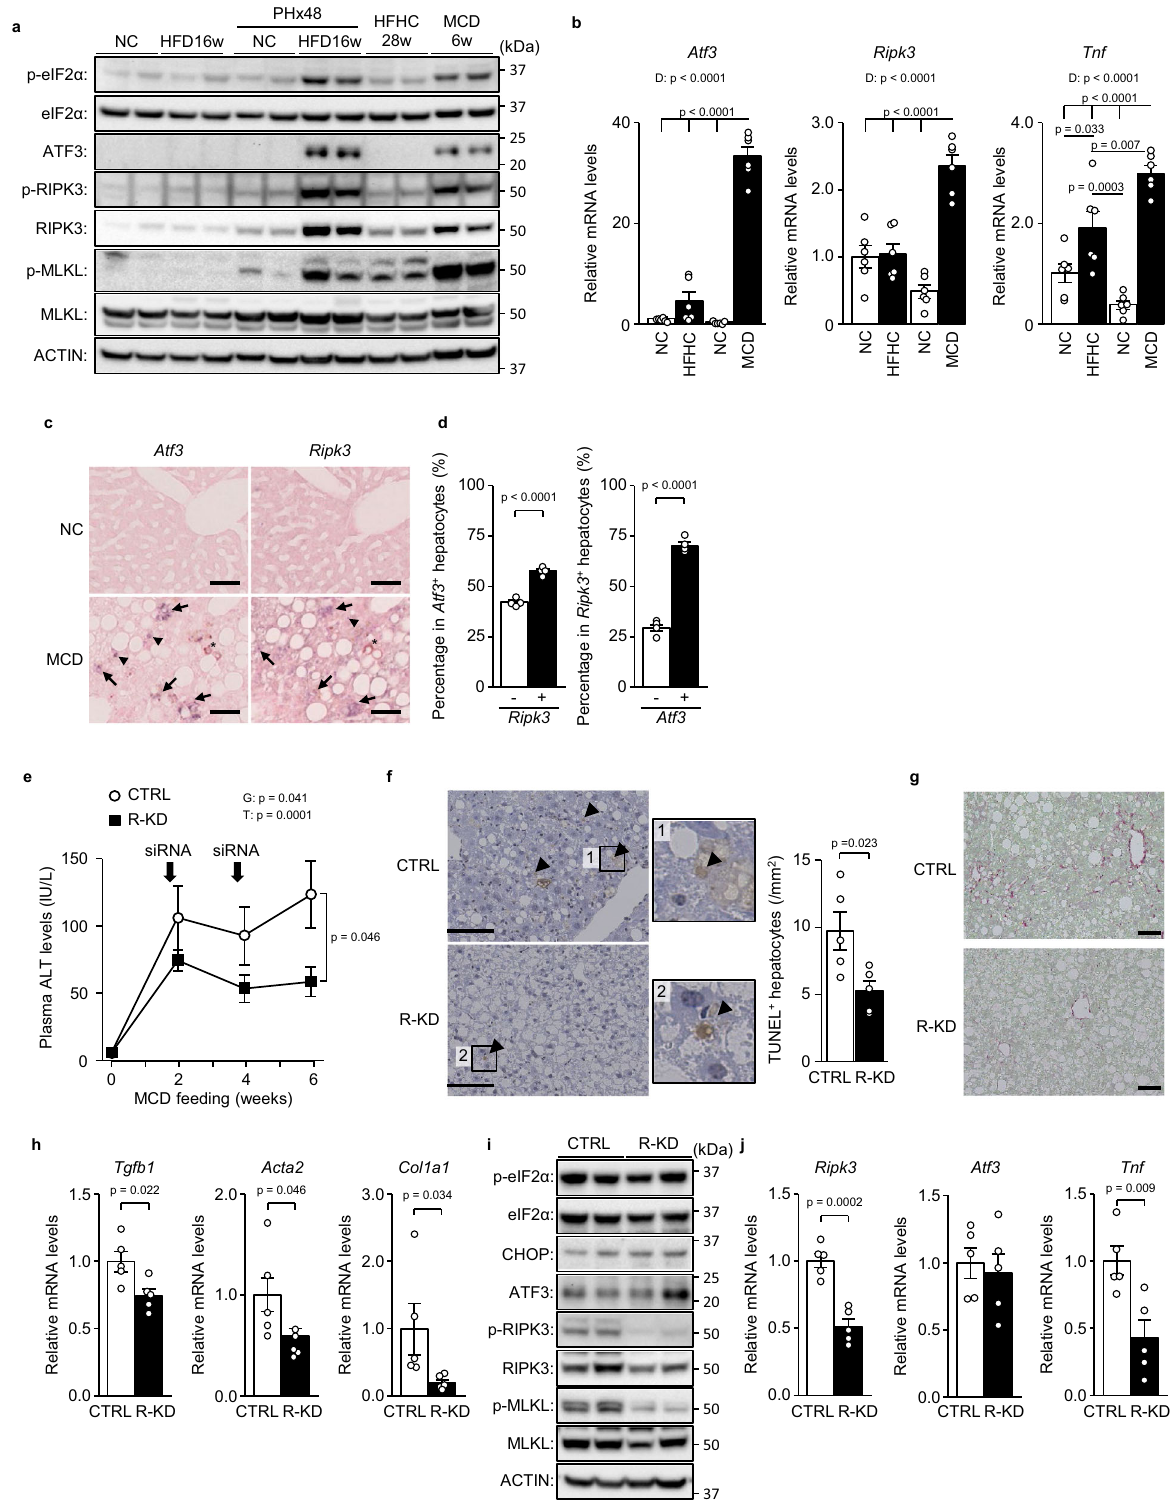
Supplementary Table 1. Protein bands were visualised using the Che- miDoc Touch Imaging System with Bio-Rad CFX Manager V1.5 (Bio- Rad, Hercules, CA). Total RNA was extracted from frozen tissue or cell samples using the SV Total RNA Isolation System (Promega, Madison, WI). cDNA was synthesised from total RNA with the PrimeScript RT reagent kit (Takara Bio, Shiga, Japan). Quantitative polymerase chain reaction (PCR) was performed using the SYBR Premix ExTaq2 kit